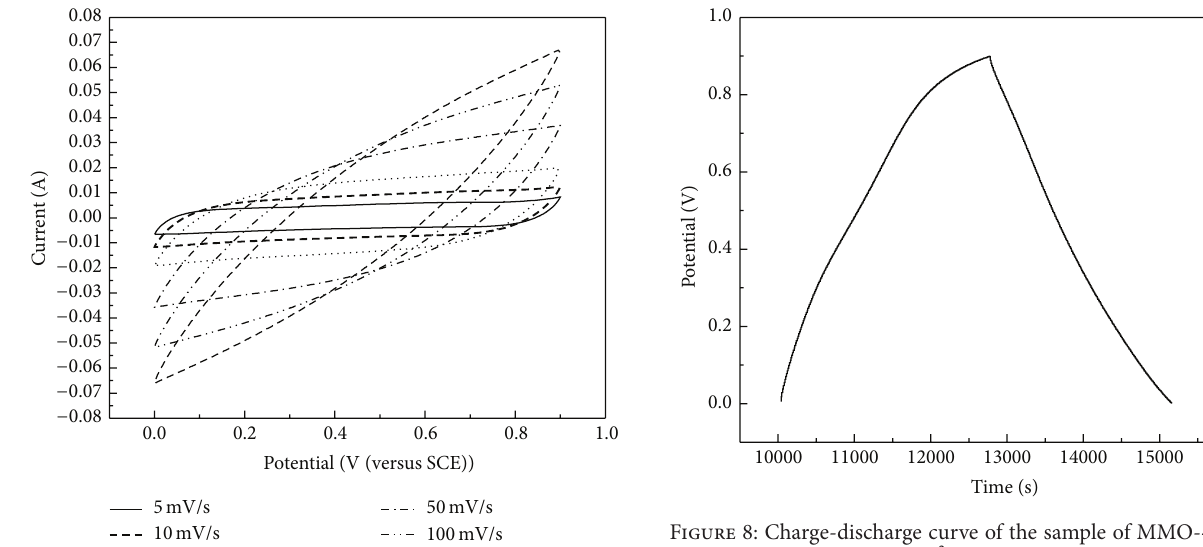
Figure 8: Charge-discharge curve of the sample of MMO-4 at the current density of 0.5 mAcm −2